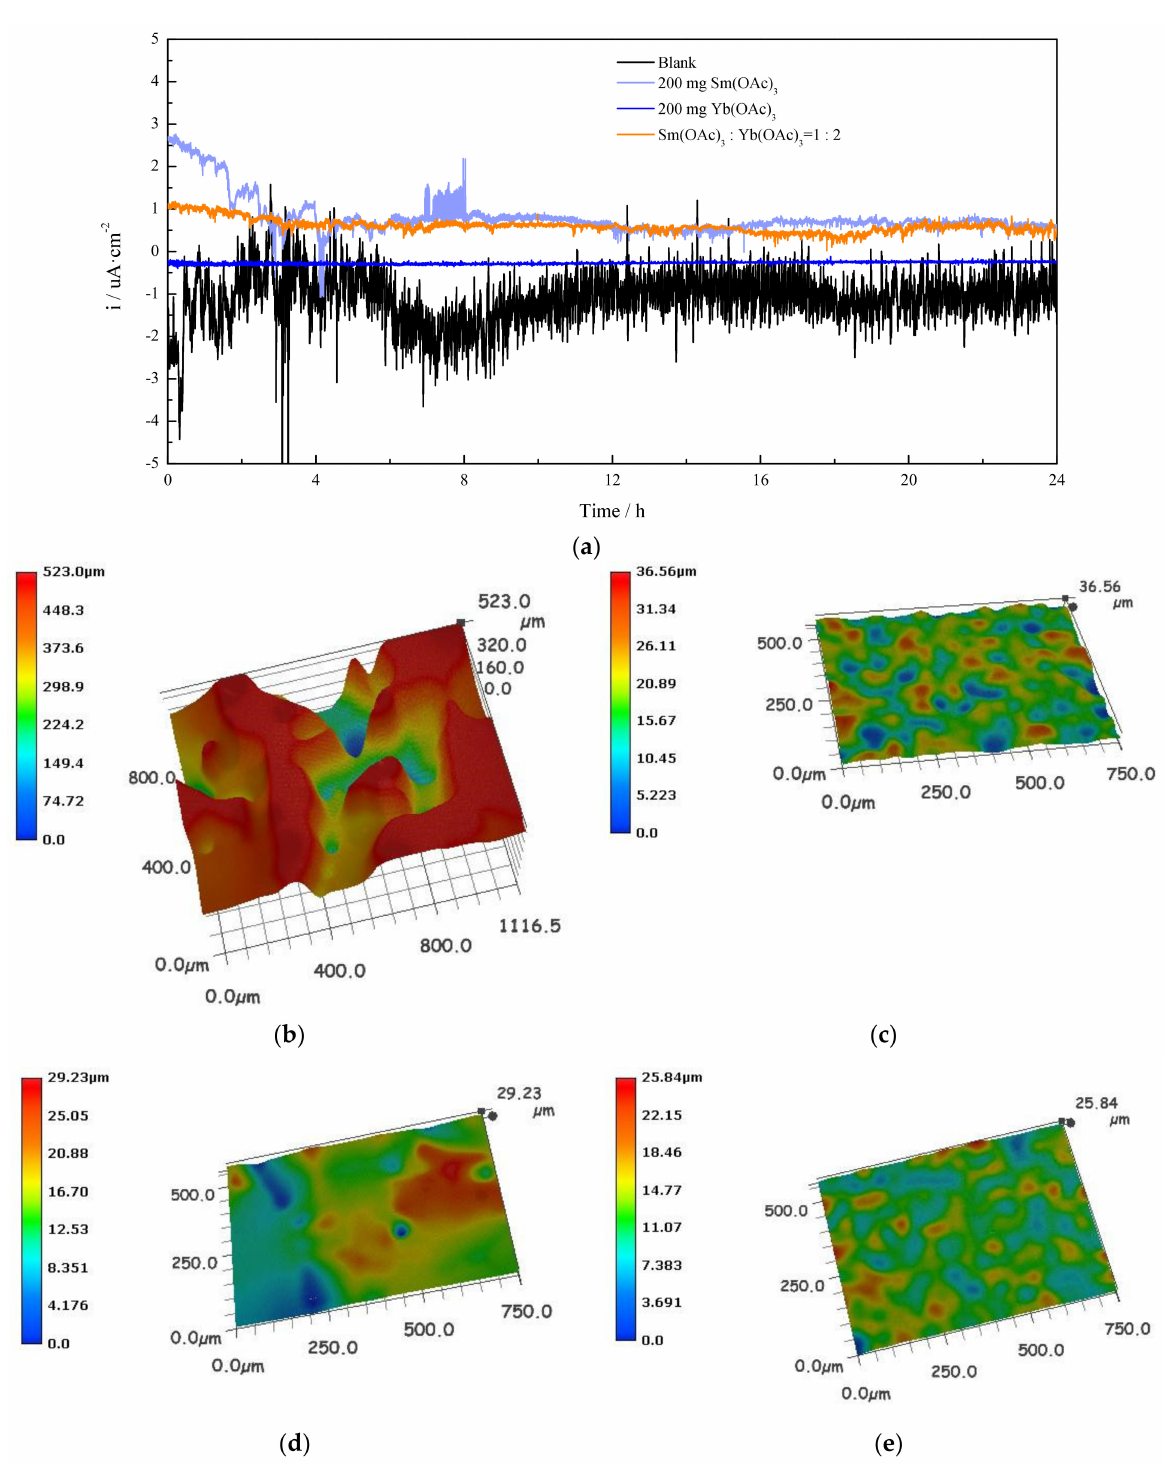
Figure 5. ( a ) Time evolution diagram of noise current and 3D microscopic morphology characteristics after electrochemical noise test: ( b ) blank, ( c ) 200 mg/L Sm(OAc) 3 , ( d ) 200 mg/L Yb(OAc) 3 , and ( e ) Sm(OAc) 3 :Yb(OAc) 3 =